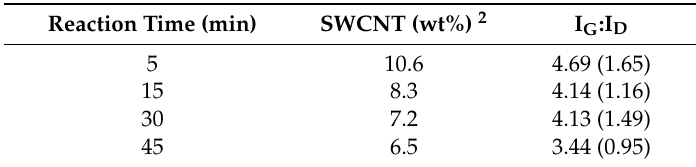
Figure 8. Raman spectra (514 nm) of the Cu-SWCNT composites prepared by electroless deposition after a reaction time of 30 min. Table 7. The I G :I D ratio determined from the Raman spectrum (514 nm) of Cu-SWCNT composites via electroless deposition at a bath temperature of ~90 °C. 1